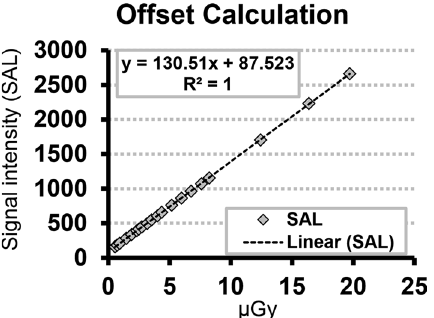
Figure 7. Detector response Pixel Value vs Entrance Air